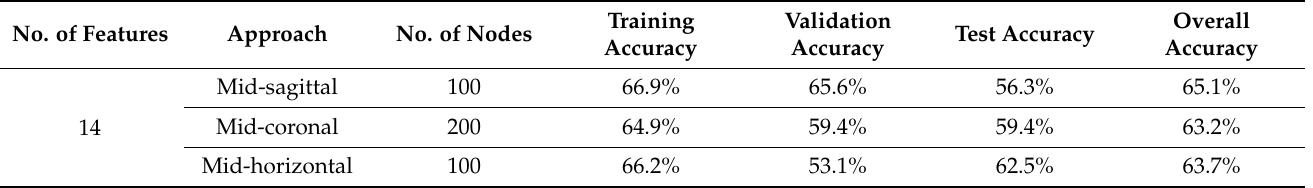
Table 6. Performance of the best OST prediction systems, with volumetric and location features and age factor, using NN . No. of